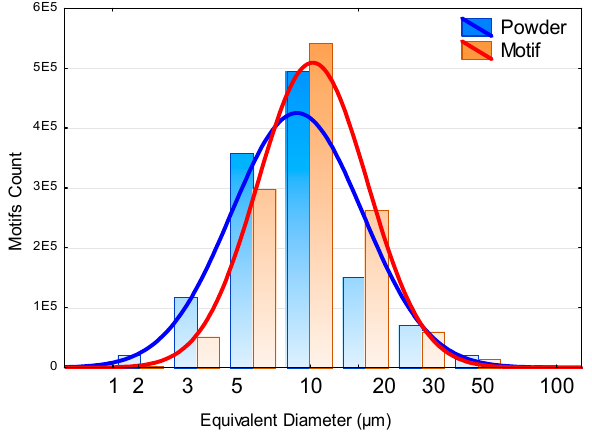
Figure 17. The number of motif counts vs. equivalent diameter. However, it is essential to underline the lack of outliers. This homogeneous statistical distribution verifies the morphological method to segments by heterogeneous zones. A comparison between this distribution of motifs and the distribution of initial powders